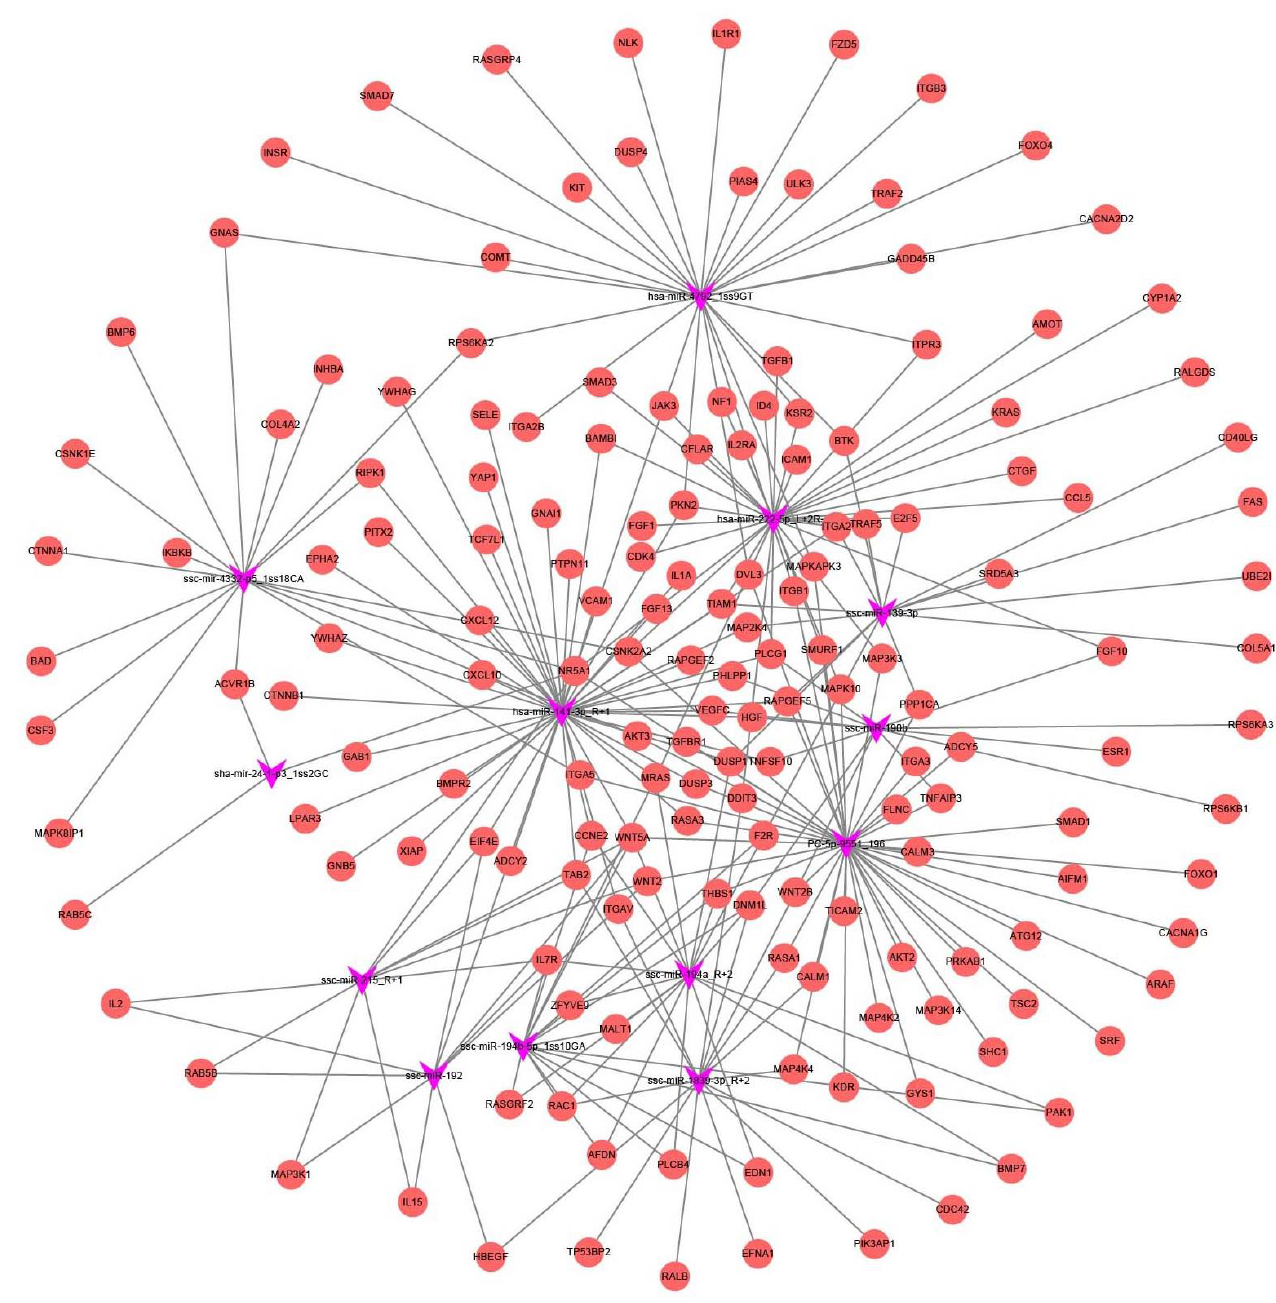
Figure 5. DEmiRNA – Gene network analysis. The miRNA – Gene network was built based on the interactions between miRNAs and the intersected target genes. This analysis illustrates the key regulatory functions of the identified miRNAs and their target genes. For the network, the diamond nodes represent miRNA, and the orange circles represent genes.